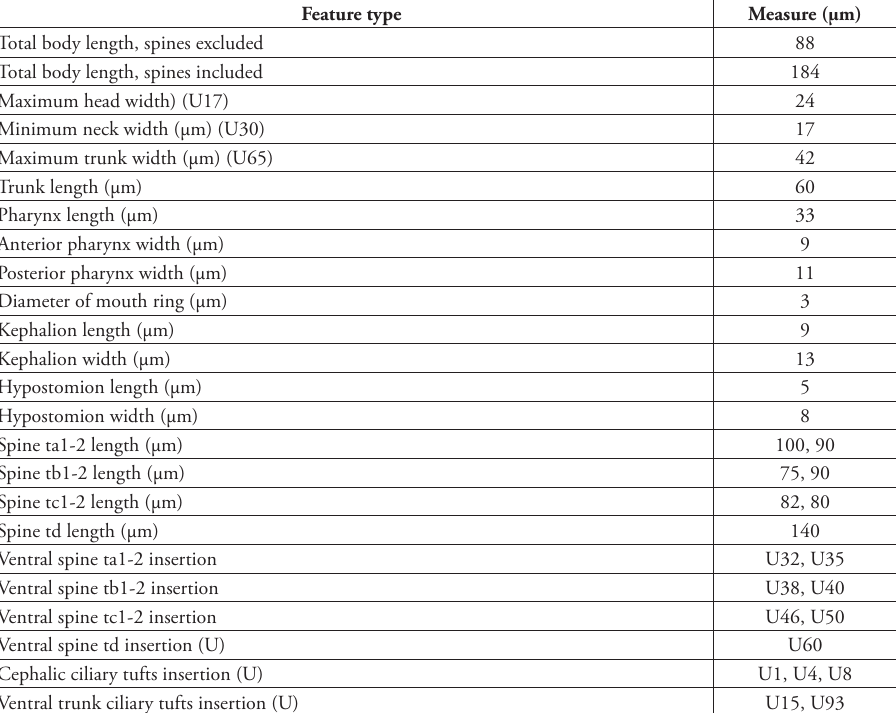
Table 1. Morphometric features of Haltidytes ooëides (Brunson, 1950): measures are expressed in μm; the relative positions of morphological structures along the body are expressed in percentage unities (U) in relation to the total body